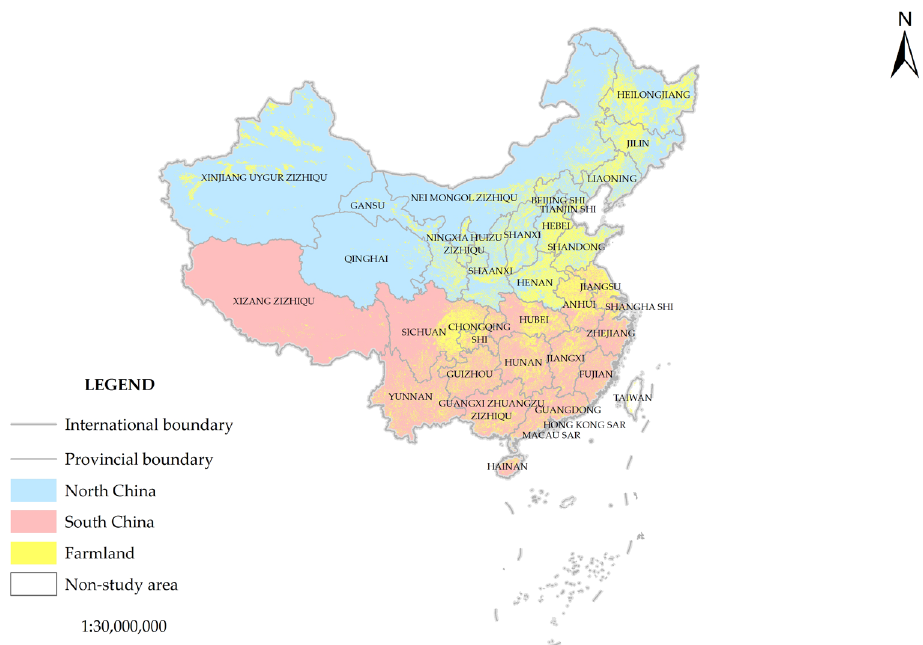
Figure 6. Farmland distribution in South and North China in 2020. Note: This figure was designed under the standard map numbered GS(2020)4619 on the website of the standard map service of the Ministry of Natural Resources [73], and the base map has not been modified. The farmland data are from the website of the Resource and Environment Science and Data Center of the Chinese Academy of Sciences [74].